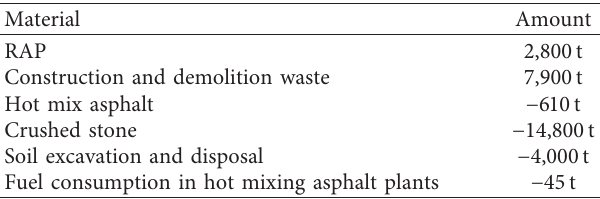
Table 2: Main environmental gains with the recycled pavement in section